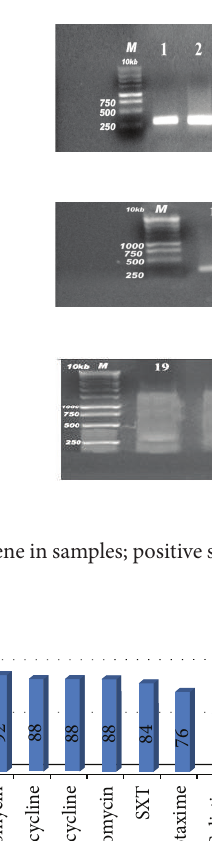
Figure 3: (a, b, c) Detection of colV plasmid gene in samples; positive samples produce band 1180bp; lane M: 1Kb DNA Ladder; lanes 3, 8, 9, 17, 19, and 24 were positive samples.